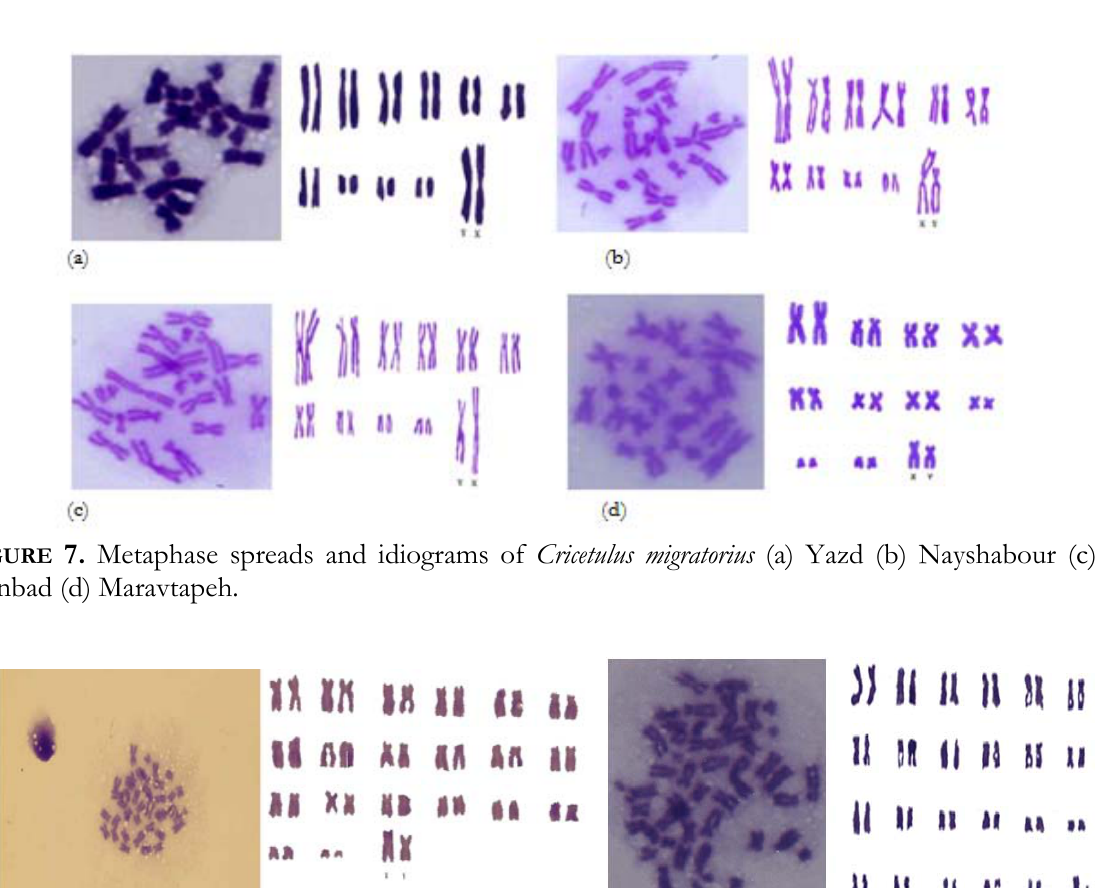
F IGURE 8. Metaphase spread and idiogram of Mesocricetus brandti.